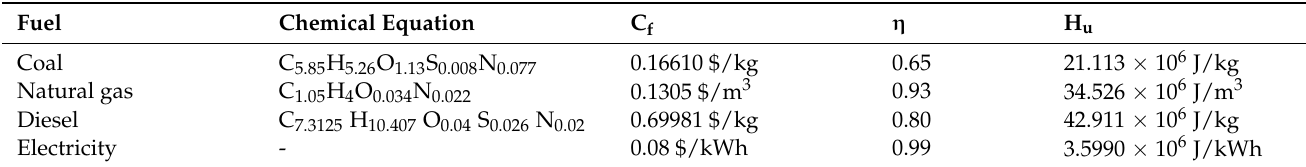
Table 3. Considered fuel characteristics